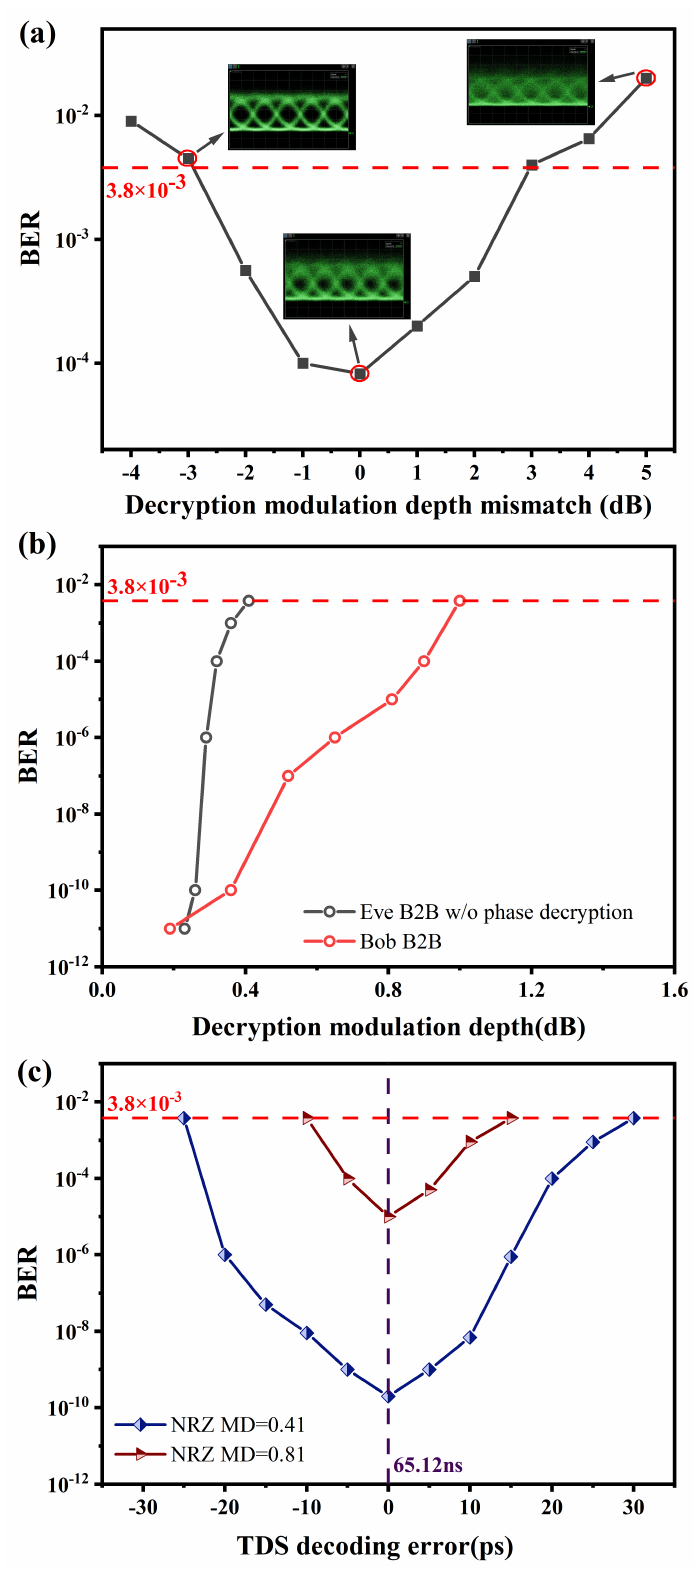
Figure 6. ( a ) Effect of decryption modulation depth mismatch on received BER; ( b ) measured BER curves versus phase modulation depth for a legal user and an eavesdropper; and ( c ) effect of TDS parameter deciphering deviation on the accuracy of decrypted